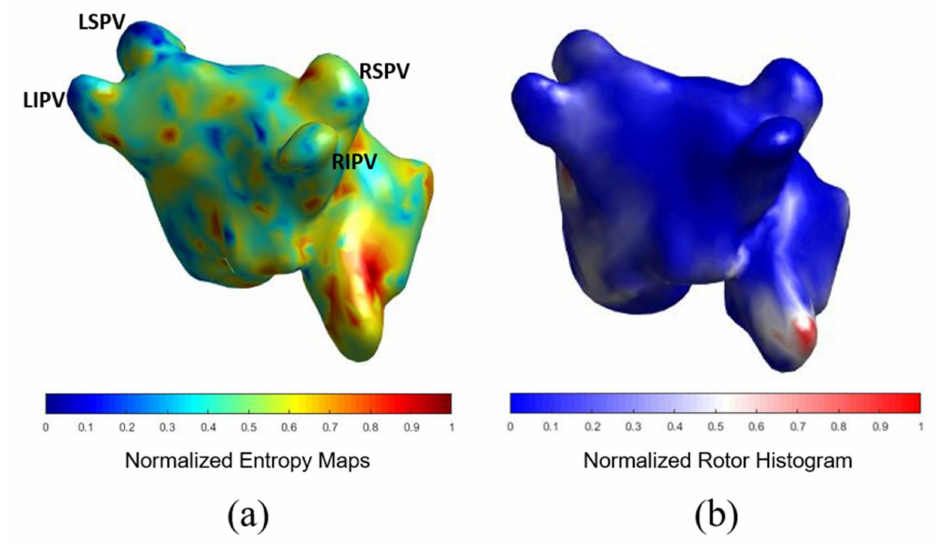
Figure 3. Comparison of simulations entropy maps with histogram of rotors in sample case. ( a ) shows the results for the computational method. ( b ) shows the histogram of rotors computed from the ECGI.